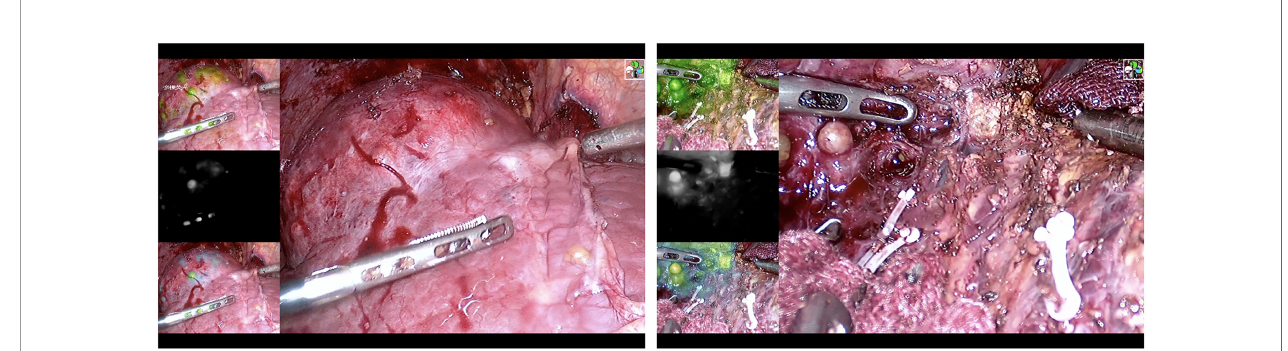
FIGURE 1 | Positive staining. Liver resection under ICG navigation step by